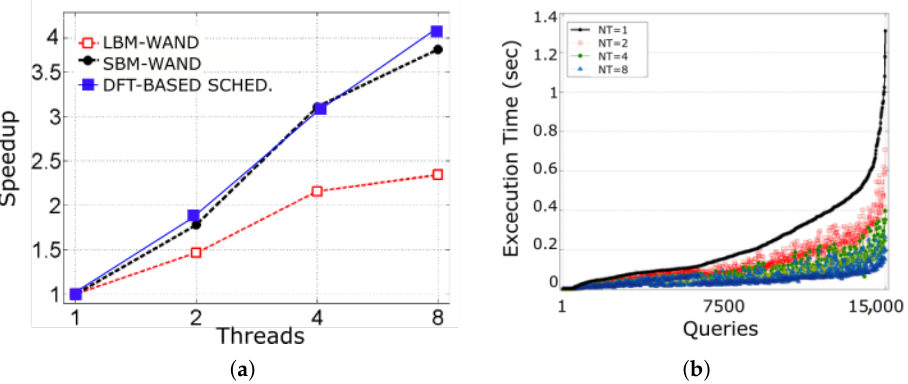
Figure 7. ( a ) Speedup reported by the LBM-WAND, the SBM-WAND query processing strategies and the DFT-based scheduler. ( b ) Execution time in seconds reported with up to 8 threads by the DFT-based